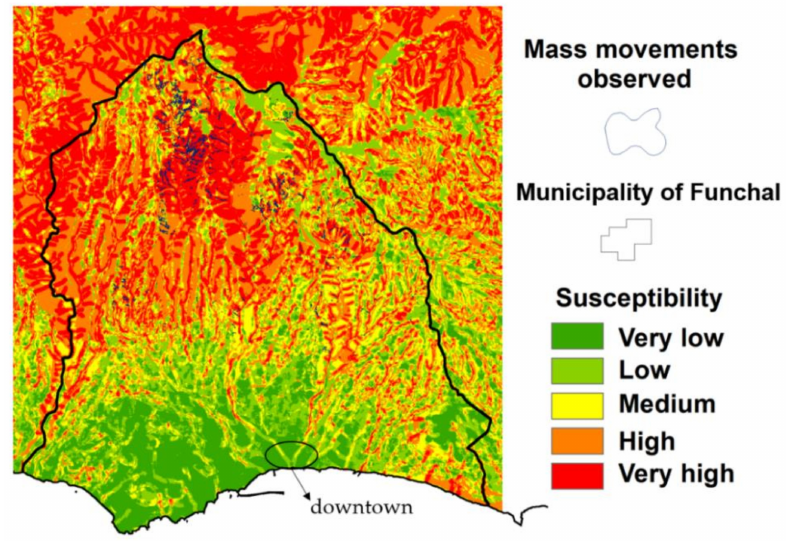
Figure 7. Susceptibility to mass movements in